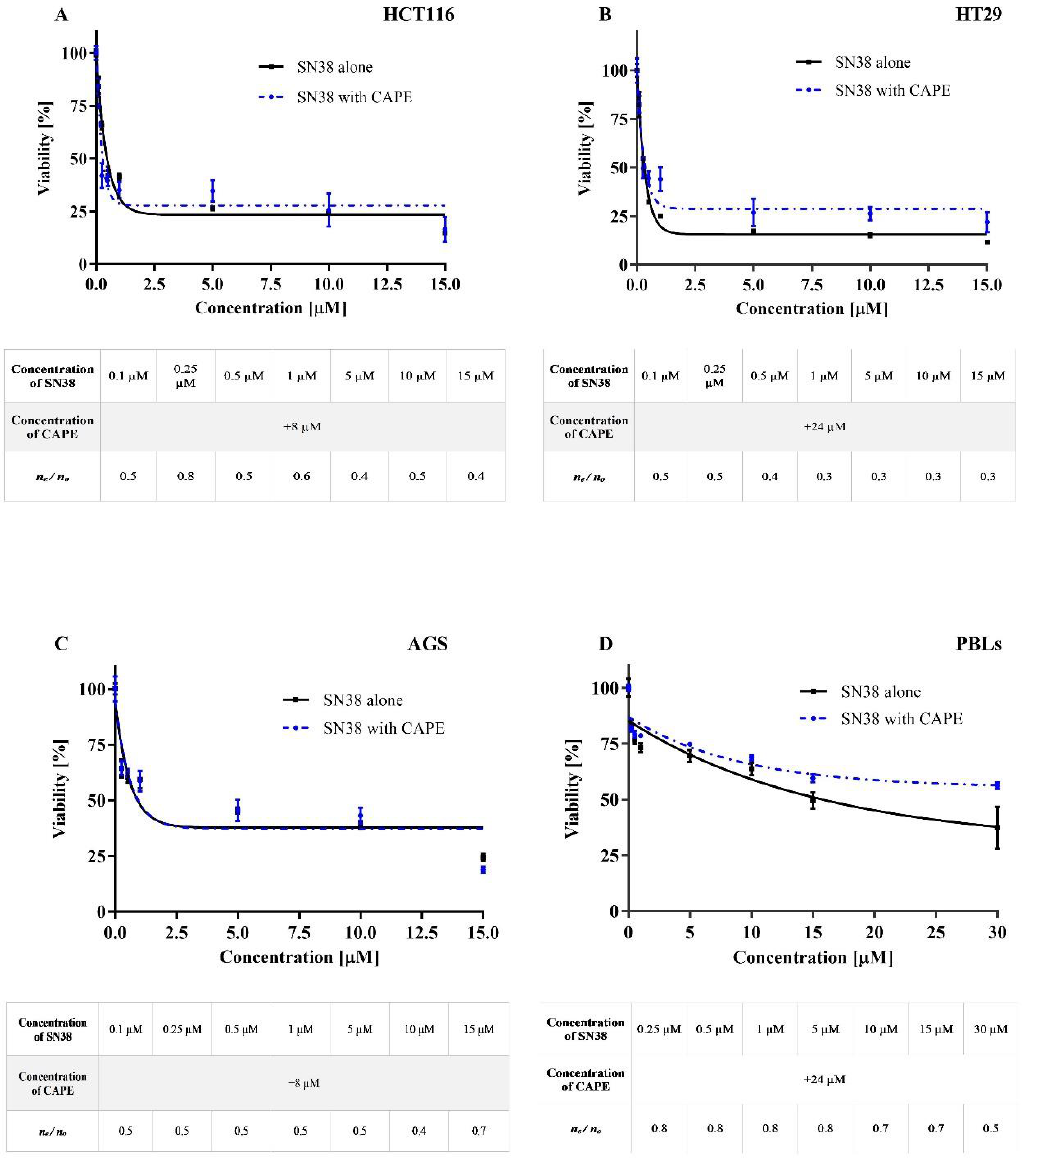
Figure 4. The e ff ect of SN38 and co-treatment CAPE + SN38 on HCT116 cells ( A ), HT29 cells ( B ), AGS cells ( C ) and PBLs ( D ) growth after 72 h incubation evaluated by MTT assay (the mean ± SEM) Treatment of CAPE and SN38 simultaneously shows antagonistic e ff ect on cytotoxicity of HT29, HCT116, AGS cells and PBLs. The figure under the graph show the ratio of expected cell number / observed cell number. Factor < 1 represents antagonistic e ff ect CAPE on